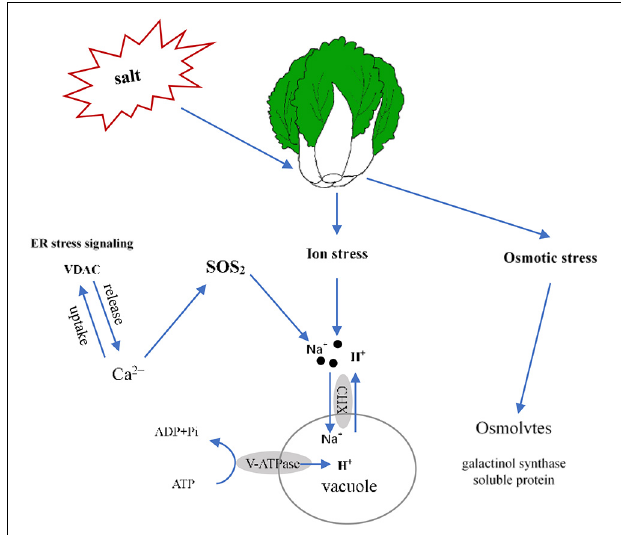
FIGURE 10 | Proposed model of the salt stress response of Qinghua45 (QH) and Biyuchunhua (BY). Salt stress resulted in Chinese cabbage suffering from ion stress and osmotic stress. Na + content increased under salt stress. Salt-tolerant plants promote the transport of sodium ions in vacuoles, increase calcium content through ER stress signaling VDAC and indirectly promote the transport of sodium ions to vacuoles through the SOS 2 pathway. Galactinol synthase and soluble protein content increased to balance the osmotic